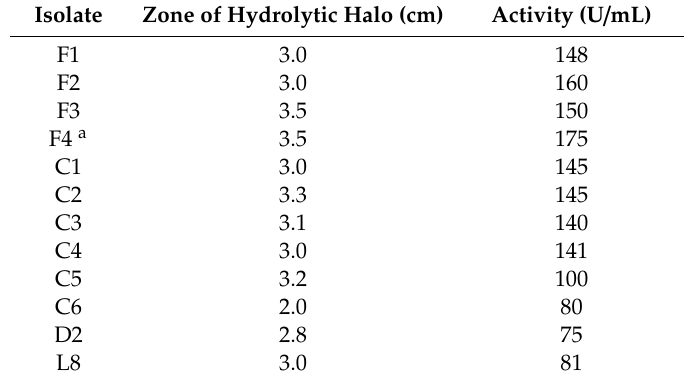
Table 1. Protease activity and zone of inhibition of isolates from Sungai Klah hot spring. Isolate